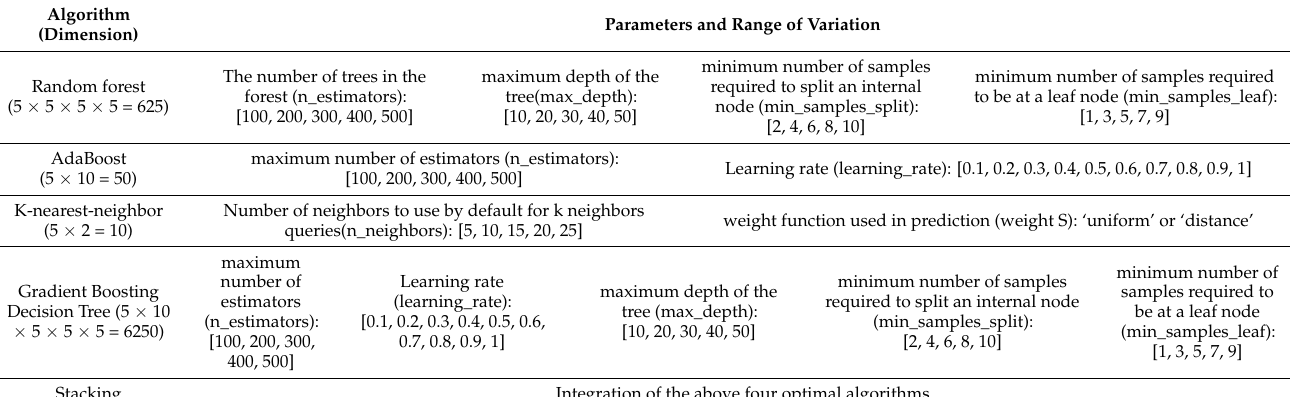
Table 1. Adjustment parameters and dynamic ranges of different ML